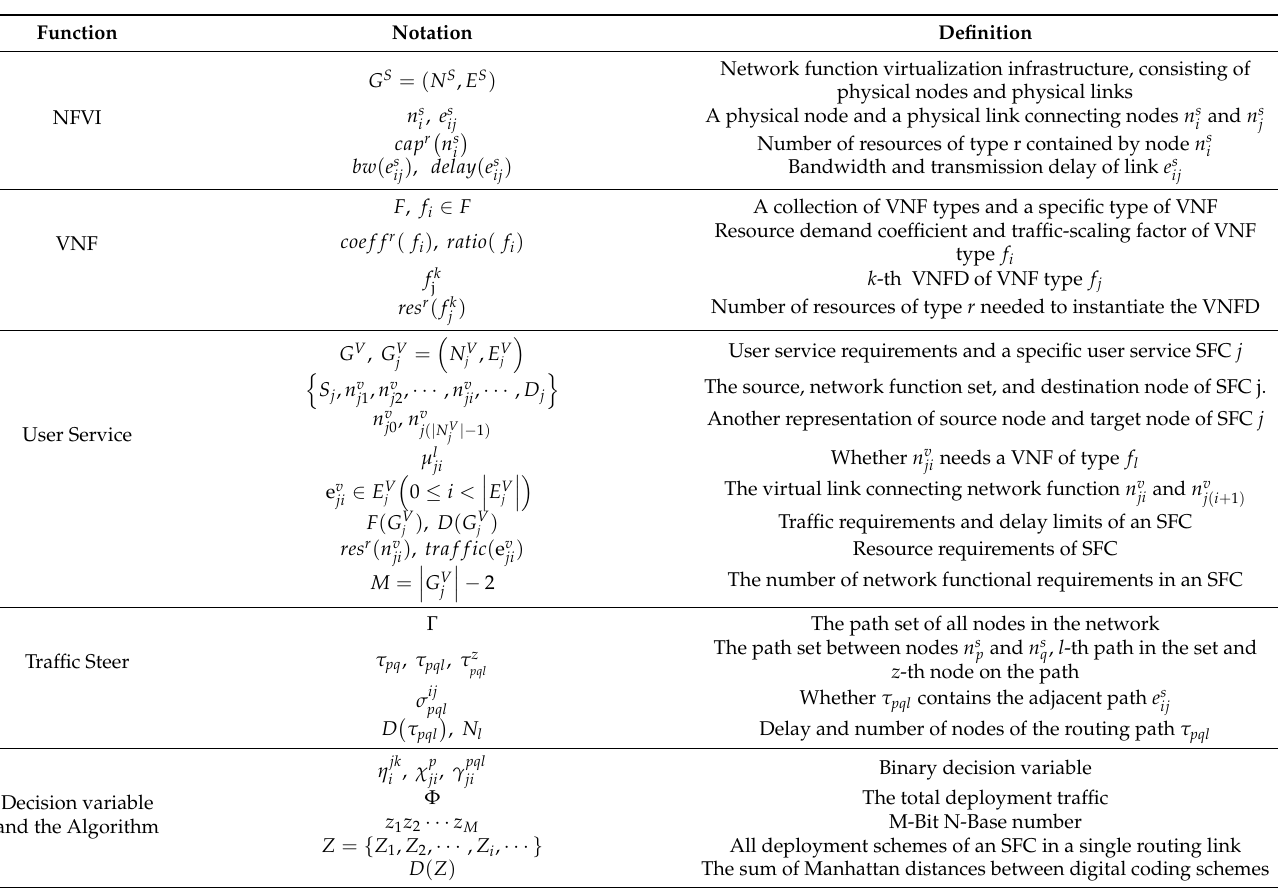
Table 1. Notations in the